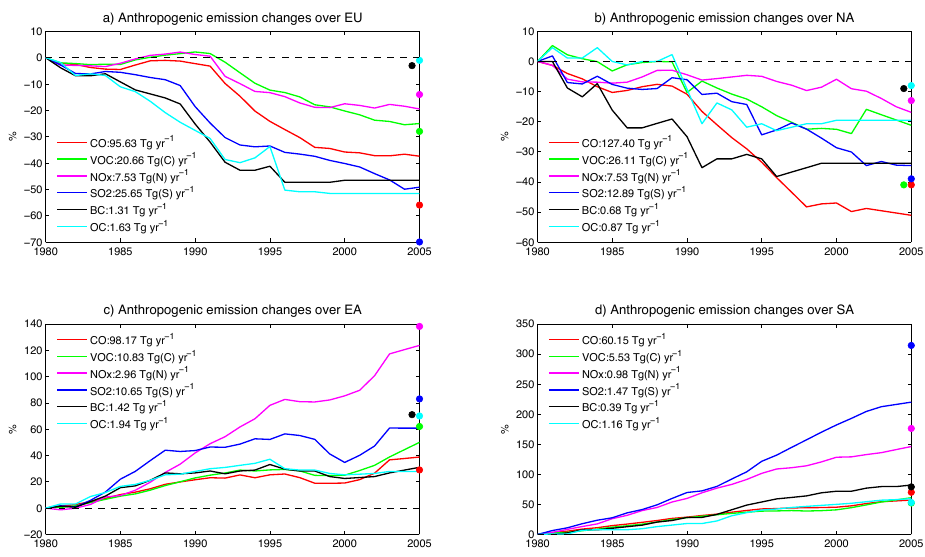
Fig. 2. Percentage changes in total anthropogenic emissions (CO, VOC, NO x , SO 2 , BC and OC) from 1980 to 2005 over the four selected regions as shown in Fig. 1: (a) Europe, EU; (b) North America, NA; (c) East Asia, EA; (d) South Asia, SA. In the legend of each regional plot, the total annual emissions for each species are reported for the year 1980. The colored points represent the percentage changes in regional emissions between 1980 and 2005 in Lamarque et al. (2010) which includes recent assessments in the projections for the year 2005.